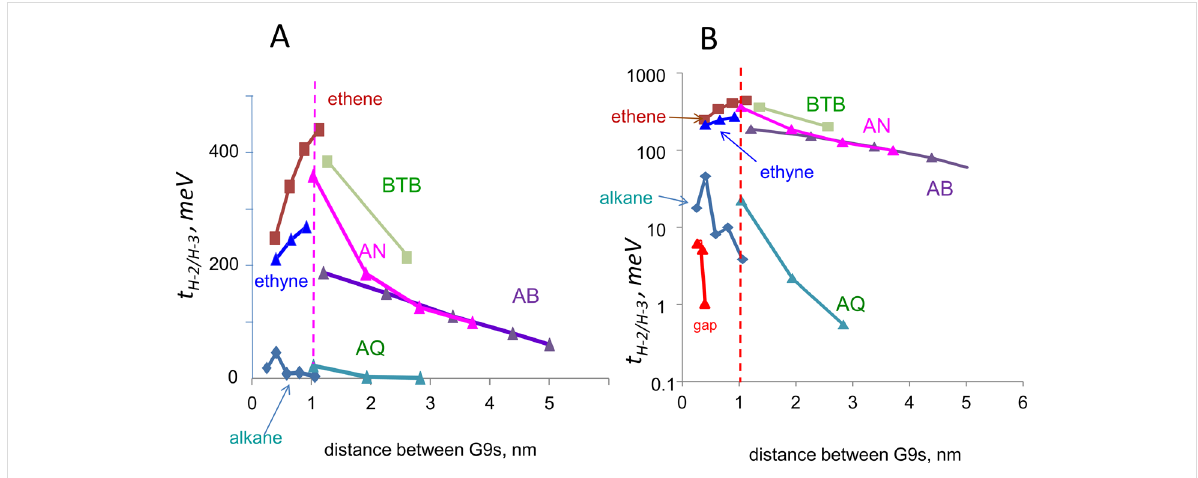
Figure 7: A) t H − 2/H − 3 calculated for the planar geometries of the indicated G9–molecule–G9 clusters with various molecular oligomers with lengths from 0.2 to 5 nm. B) same data as panel A on a log scale. BTB = bis(thienyl)benzene, AN = 2-anthracene, AB = azobenzene, ethene = trans - oligoethenylenes, ethyne = oligoethynylenes, AQ = anthraquinone.